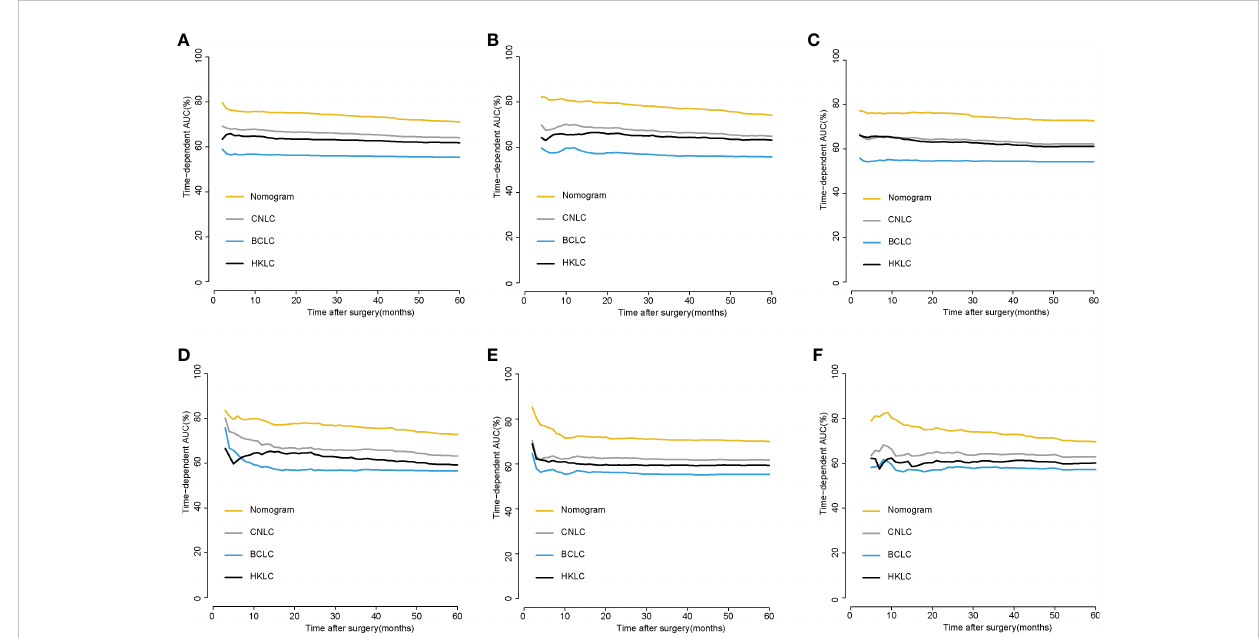
FIGURE 2 Time-dependent AUC of using the nomogram to predict recurrence and OS probability within 5 years in the training cohort (A, B) ,internalvalidation cohorts (C, D) and external validation cohorts (E, F)